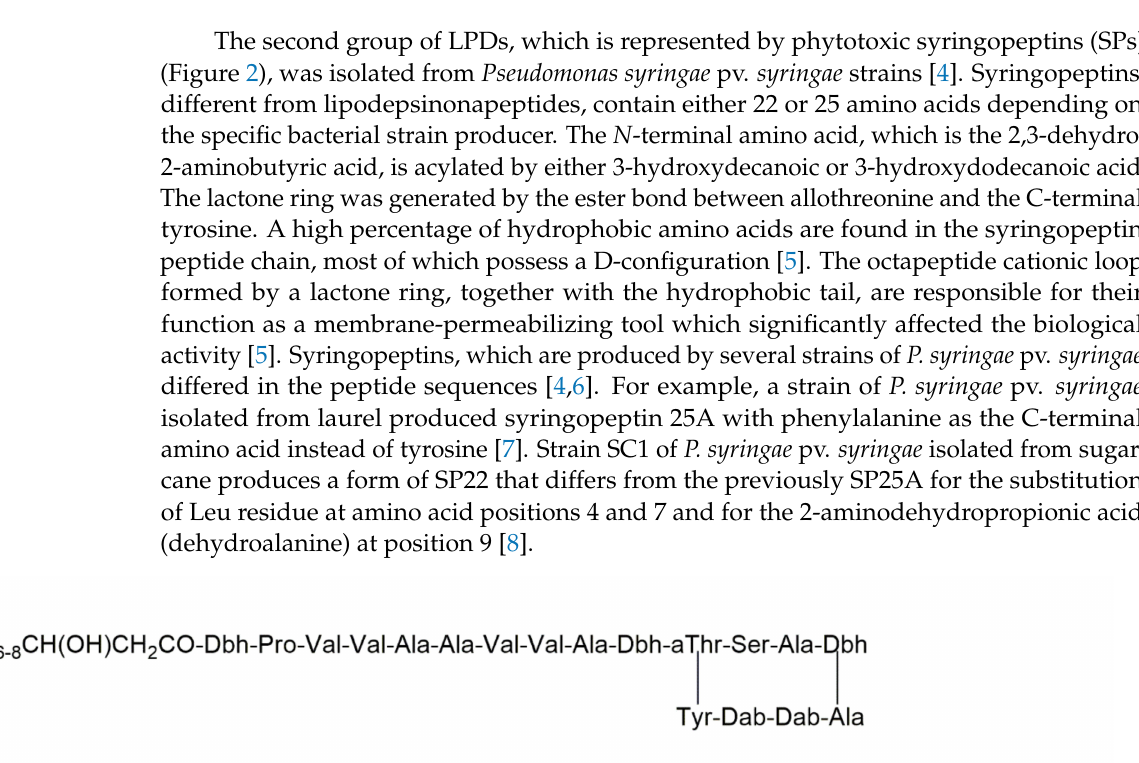
Figure 1. Structures of syringomycin, syringostatin, syringotoxin, and pseudomycin. Abbreviations of non-standard amino acids: Asp(3-OH), 3-hydroxyaspartic acid; Dab, 2,4-diaminobutyric acid; Dhb, 2,3-dehydroaminobutyric acid; Hse, homoserine; Orn, ornithine; Thr(4-Chl), 4-chlorothreonine; aThr, allothreonine.